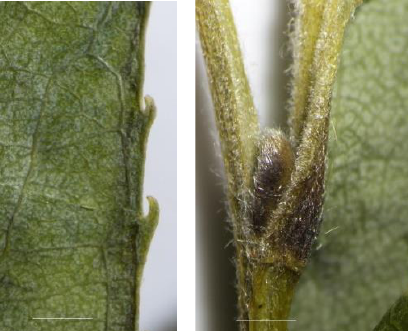
Figure 2. Salix babylonica var. sacramenta . Leaf margin ( left ). Branchlet with the bud ( right ).